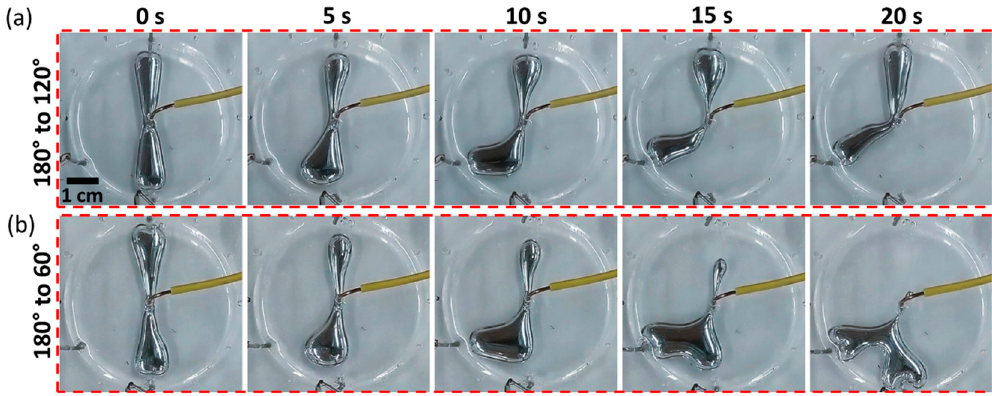
Figure 4. Exploring the dynamic morphological control of the EGaIn droplet by changing the angle between the patterned protrusions from 180 ◦ to ( a ) 120 ◦ , and ( b ) 60 ◦ . A series of snapshot images captured at 0, 5, 10, 15 and 20 s after applying potential to different cathodes are